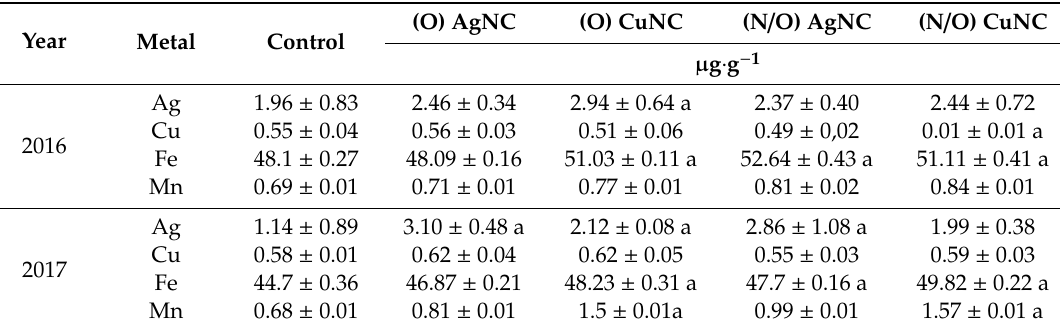
Table 4. Content of metal ions in rapeseed